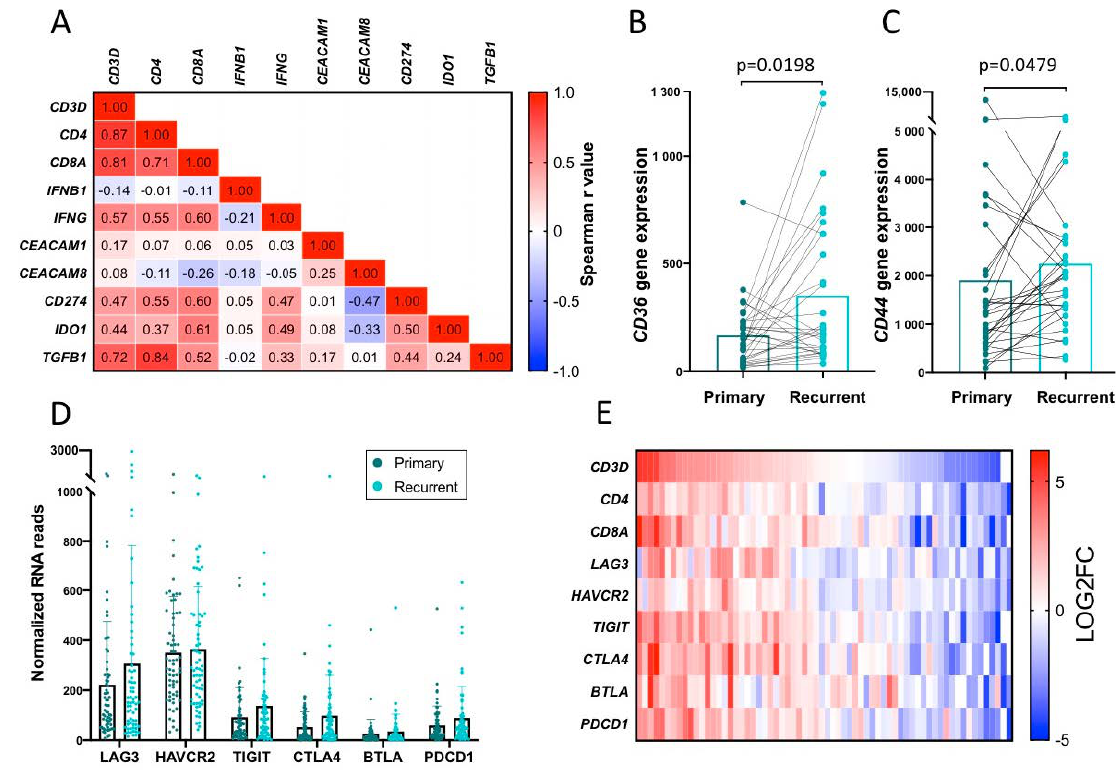
Figure 6. Validation of findings in an independent cohort of 66 patients with RNA seq data from primary and recurrent tumors described in Kreuzinger et al. [37] ( A ) Spearman correlation matrix with r values, from log2 fold change values of the expression of selected genes from the primary and recurrent tumor samples. Red indicates a strong positive correlation, blue indicates a strong negative correlation and white indicates no correlation. Validation of gene expression of CD36 ( B ) and CD44 ( C ). Figure ( B , C ) show patients with an increase in the T cell infiltration, with a log2 fold change > 0.5 of the CD3D gene from primary to recurrent tumors. Statistical analysis was performed with a Wilcoxon test. ( D ) Gene expression levels of immune checkpoints in primary and recurrent tumors. Statistical significance between expression levels in primary and recurrent samples was tested using multiple Wilcoxon tests. No significant changes were found with adjusted p values, false discovery rate (FDR), LAG3 : p > 0.999, HAVCR2 : p > 0.999, TIGIT : p = 0.100, CTLA4 : p = 0.057, BTLA : p = 0.100, PDCD1 : p = 0.100. ( E ) Heatmap showing the log2 fold change values of the expression of selected genes from the primary and recurrent tumor samples. Red indicates high expression and blue indicates low expression.